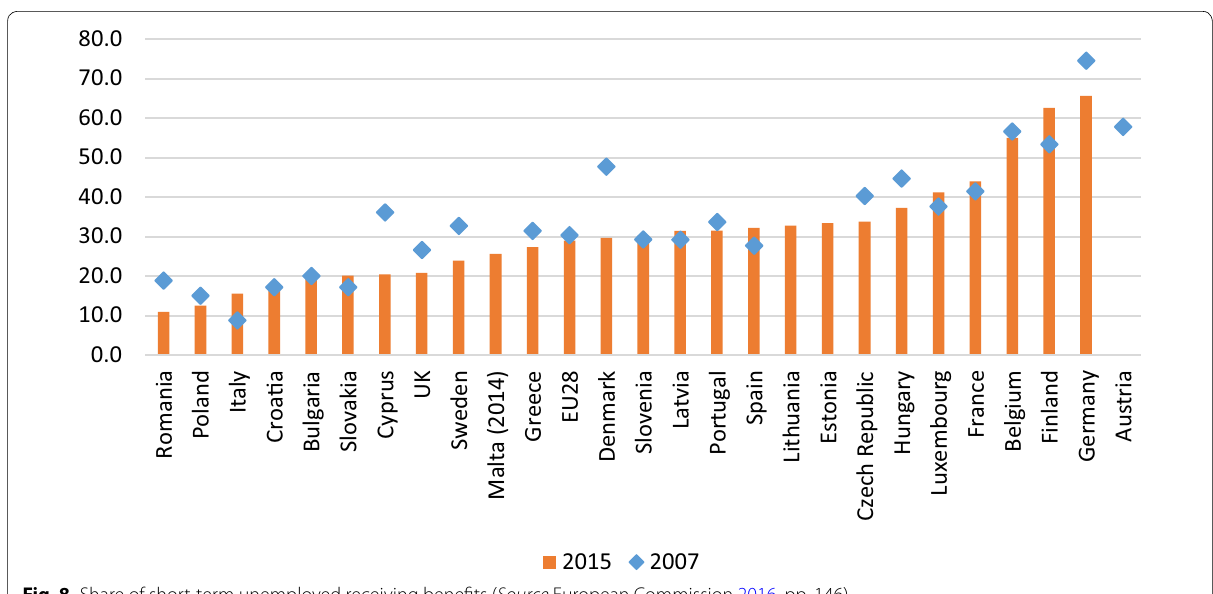
Fig. 8 Share of short-term unemployed receiving benefits ( Source European Commission 2016, pp. 146)